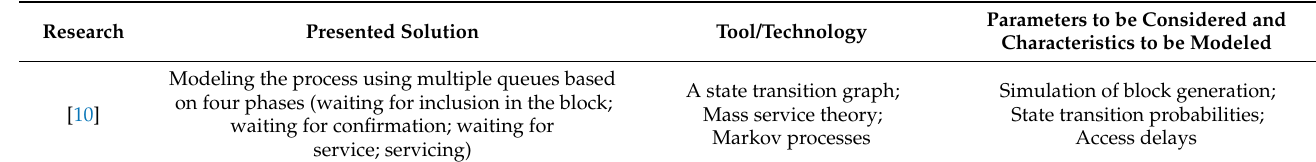
Table 1. Analytical modeling solutions for blockchain